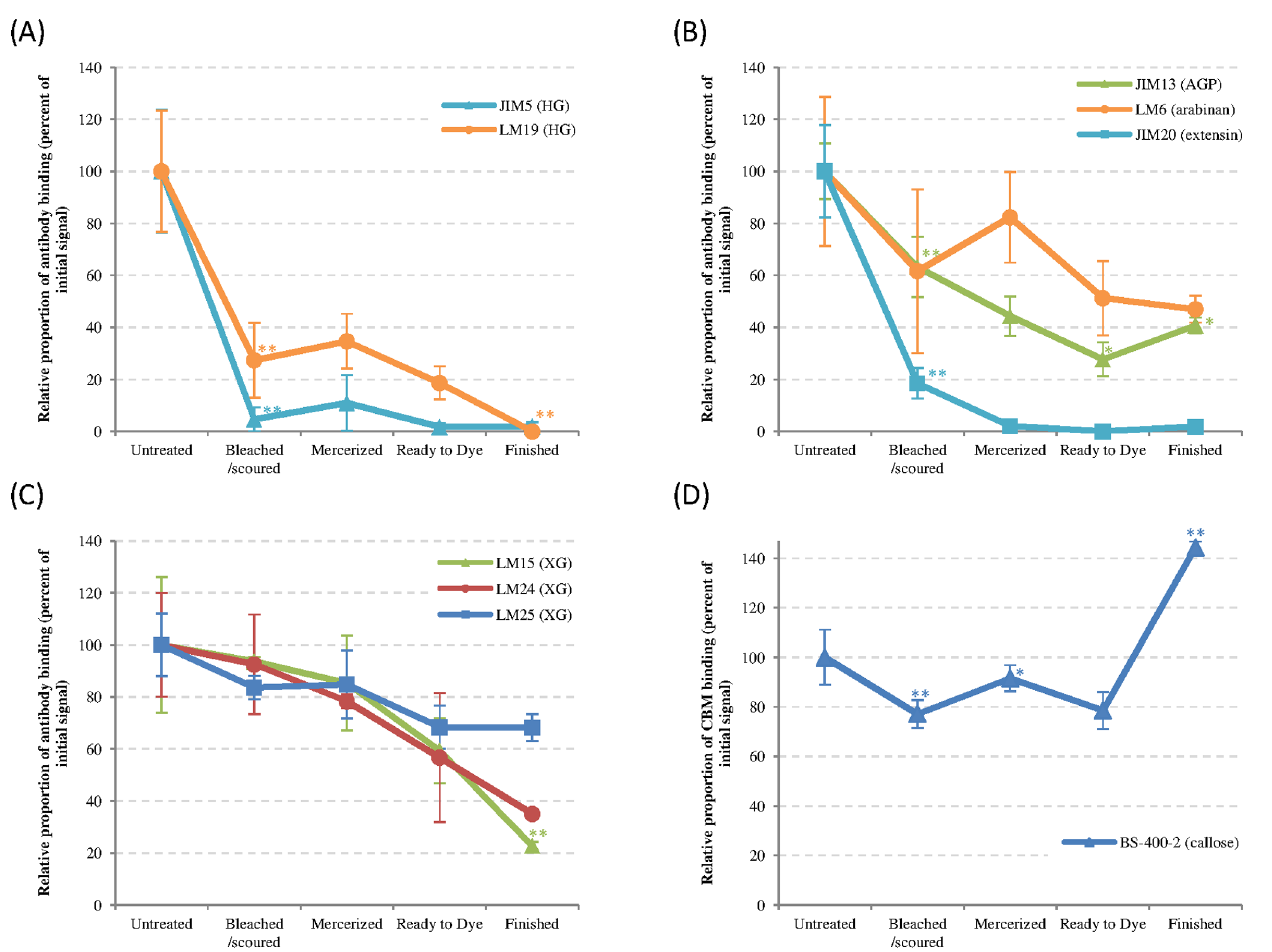
Fig. 3. Comprehensive microarray polymer profiling of powdered textile processing samples. Detection of epitopes using the following probes: (a) Anti-homogalacturonan antibodies JIM5 (triangle) and LM19 (circle); (b) anti-AGP antibody JIM13 (triangle), anti-arabinan antibody LM6 (circle) and anti- extensin antibody JIM20 (square); (c) anti-xyloglucan antibodies LM15 (triangle), LM24 (circle) and LM25 (square); (d) anti-callose antibody BS-400-2. Data represent the sum of CDTA and NaOH extracts. Error bars represent standard deviation (n 5 9). * and ** indicate significant difference between a sample and the preceding one at p , 0.05 and p , 0.01,